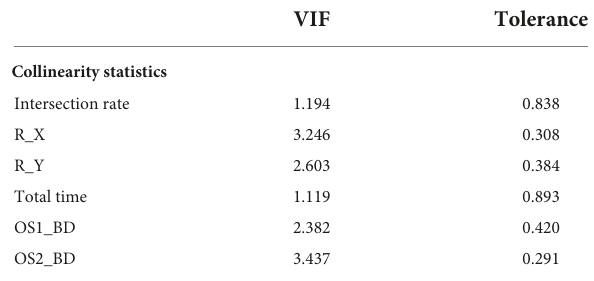
TABLE 5 Collinearity